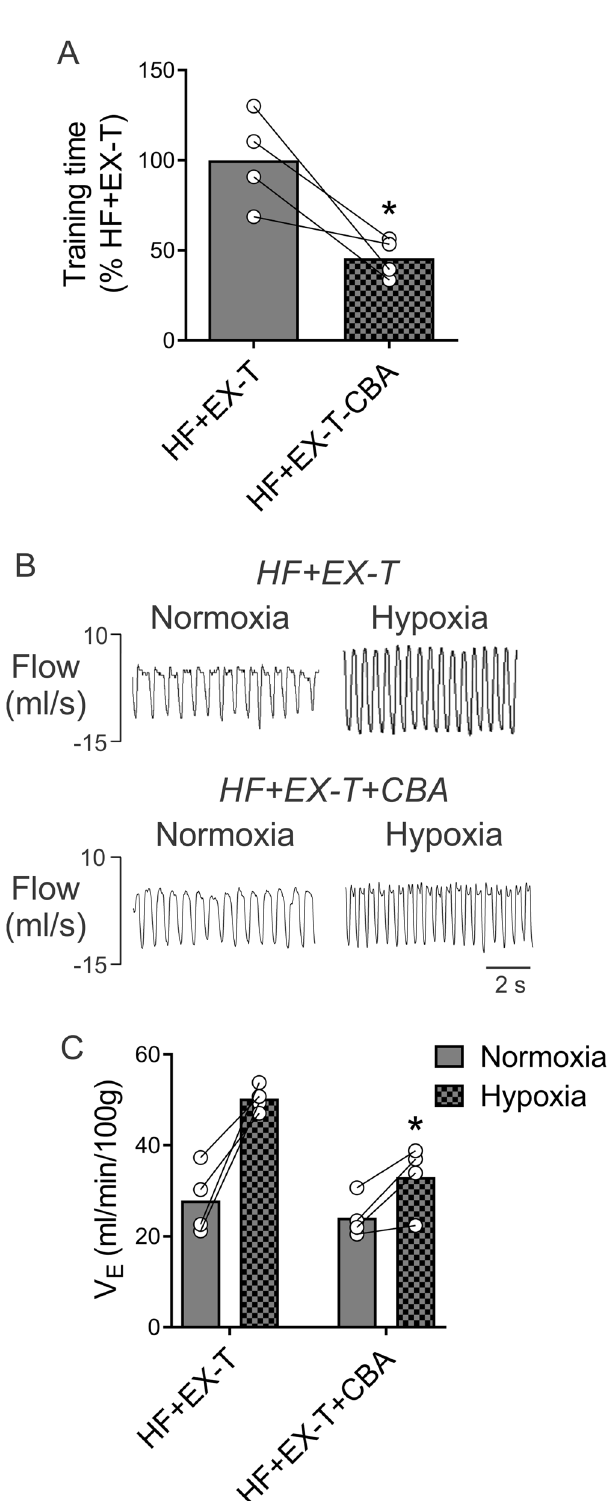
Figure 6. Carotid body ablation (CBA) in HF-EX-T rats induces a phenotypic switch from exercise tolerant to exercise intolerant. ( A ) Summary data showing training time before and after CBA in HF-EX-T rats. Note that CBA was associated with significantly lower training time in rats that were previously tolerant of EX. ( B ) Representative traces of HVR from one HF + EX-T rat before and 2 weeks post-CBA. ( C ) Summary data of minute ventilation during normoxia and hypoxia. Note that ventilatory response to hypoxia was significantly reduced after CBA. *p < 0.05 vs. HF + EX-T during hypoxia. HF + EX-T, n = 4; HF + EX-T + CBA, n =